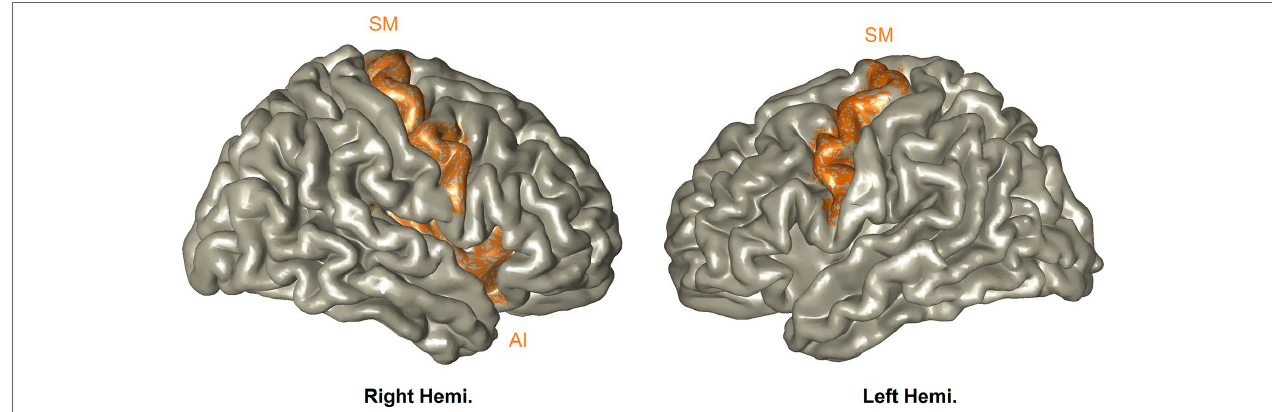
FIGURE 2 | Perception of vicarious distress. All participants activated the bilateral SM and right-AI (P cluster- corrected < 0.001), and this activation was expressed as alpha-band